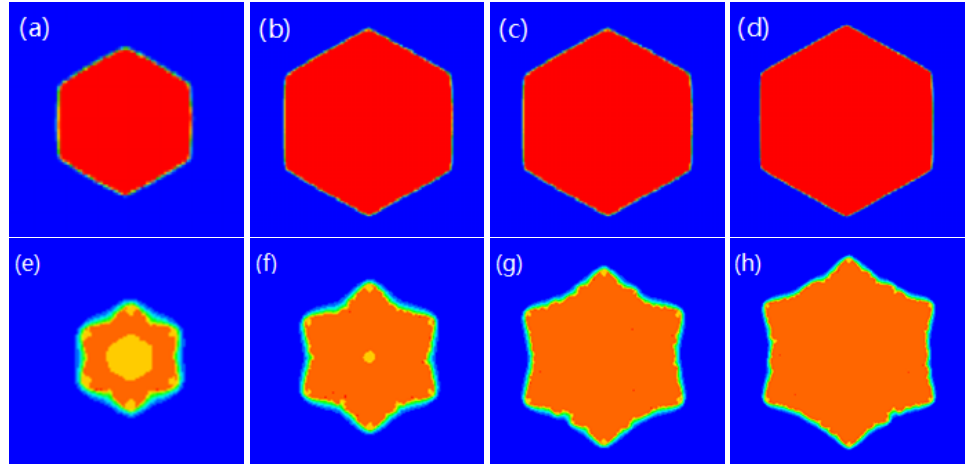
Figure 8. When K 0 = 1.25 under pure diffusion conditions, the simulated morphology of dendrites and the corresponding temperature field distribution. (Under pure diffusion conditions, ( a – d ) is the crystalline morphology of the polymer, and ( e – h ) is the corresponding temperature field).